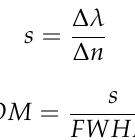
Figure 3. Two RI sensor properties for coupling via an equilateral triangular prism. ( a ) The resonance wavelength as a function of analyte RI with a linear fit produced a slope of 7724.9 nm/RIU; and ( b ) the FOM as a function of analyte RI.